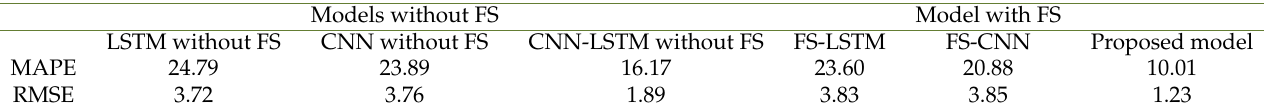
Table 3. Performance